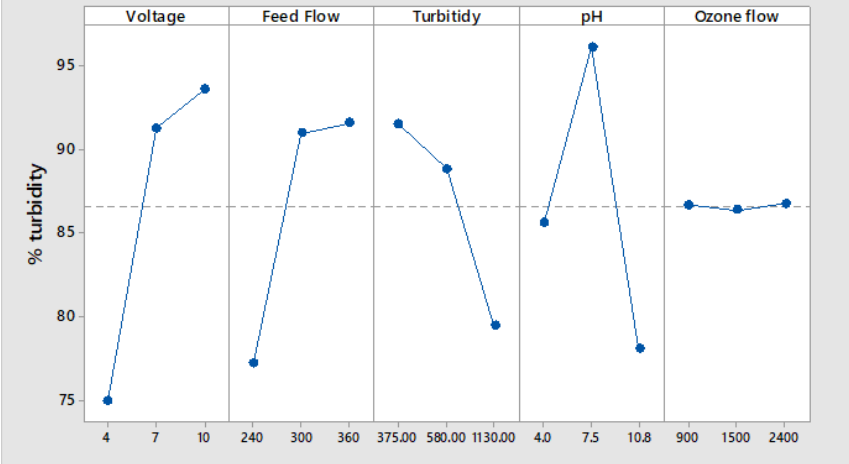
Figure 2. The effects of the operating variables on the mean turbidity removal